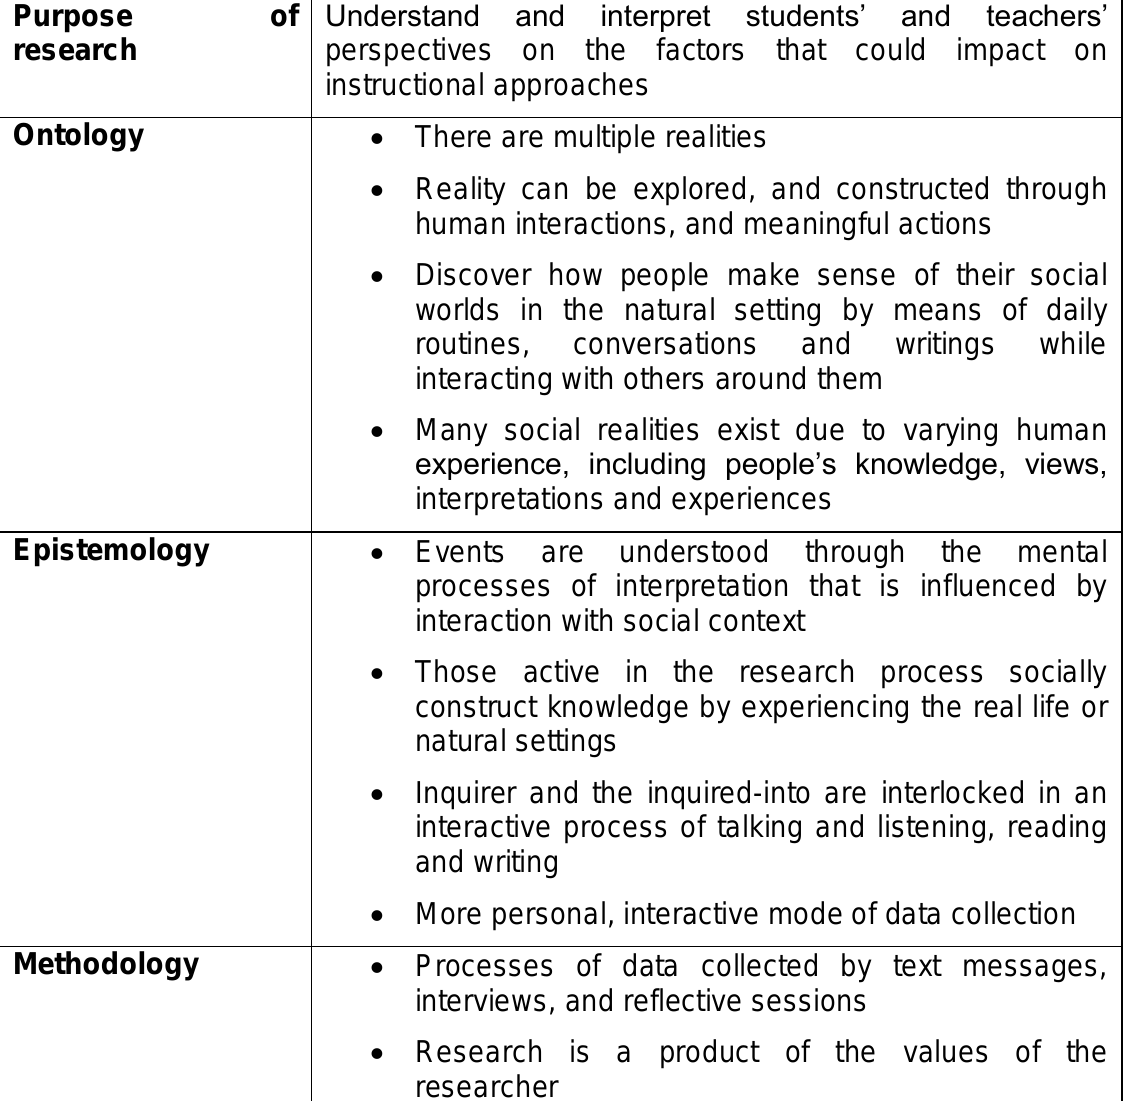
Table 3.2: The constructivist paradigm